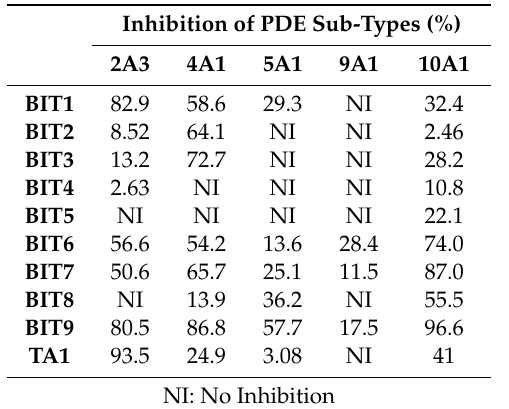
Table 3. Percentage inhibition of PDE sub-types from synthesized compounds; for PDE2A3, the compounds were measured at a concentration of 10 nM and for PDE4A1, PDE5A1, PDE9A1, and PDE10A1 at 1 µ